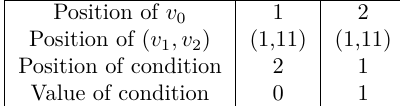
Table 7: Parameters for TYPE-II conditional cube